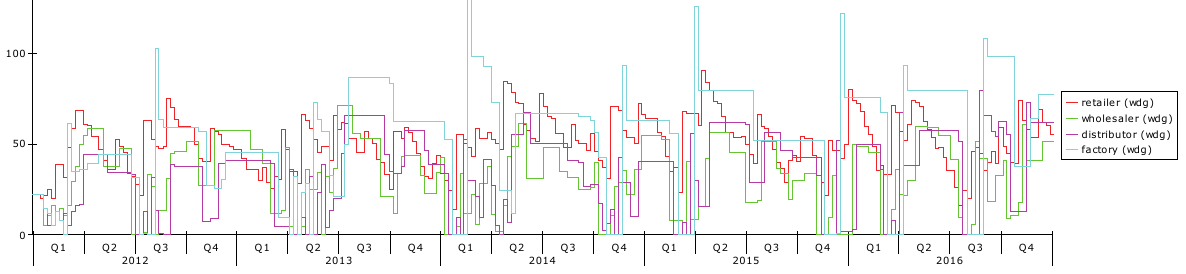
Fig. 4. A Bullwhip Scenario under decentralized Management control (Q.ty report)